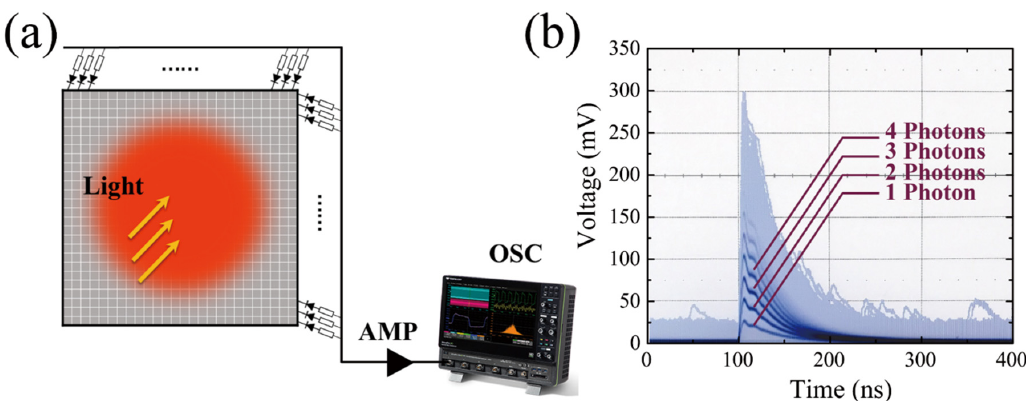
Figure 1. ( a ) Structure diagram of MPPC. AMP, amplifier; OSC, oscilloscope. ( b ) Output waveform from MPPC captured by an oscilloscope. The effective photosensitive area of MPPC (C13366-1350GA Hamamatsu) is 1.3 × 1.3 mm 2 with 667 pixels. ( b ) Output waveform displayed by an oscilloscope. The output pulse duration is about 40 ns.